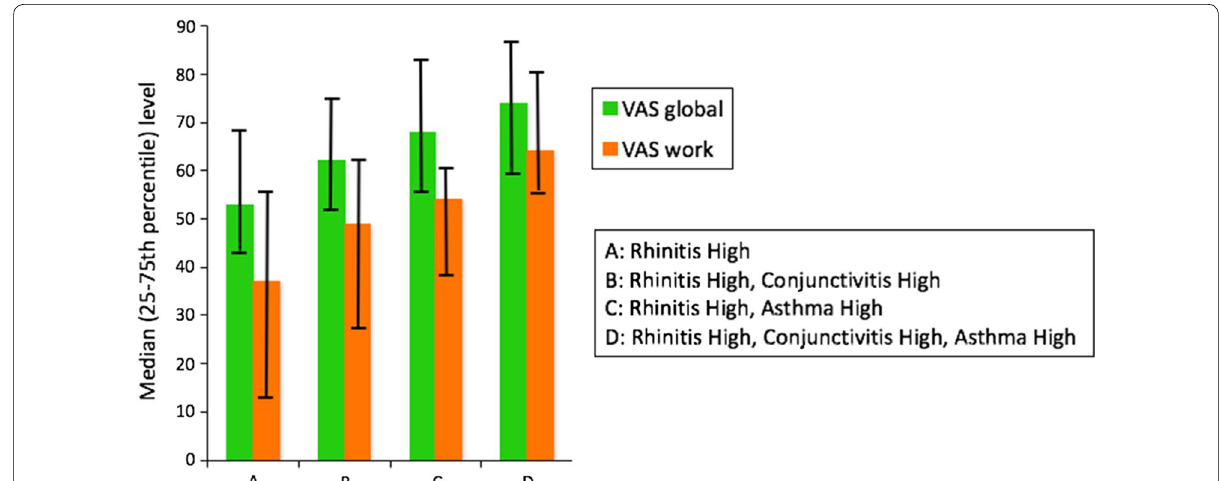
Fig. 9 VAS levels in severe rhinitis depending on multimorbidity (from Bousquet et al. [60])